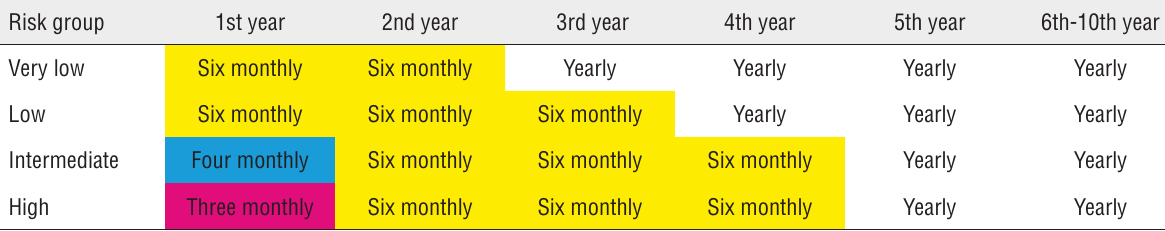
Table 8 - Follow-up